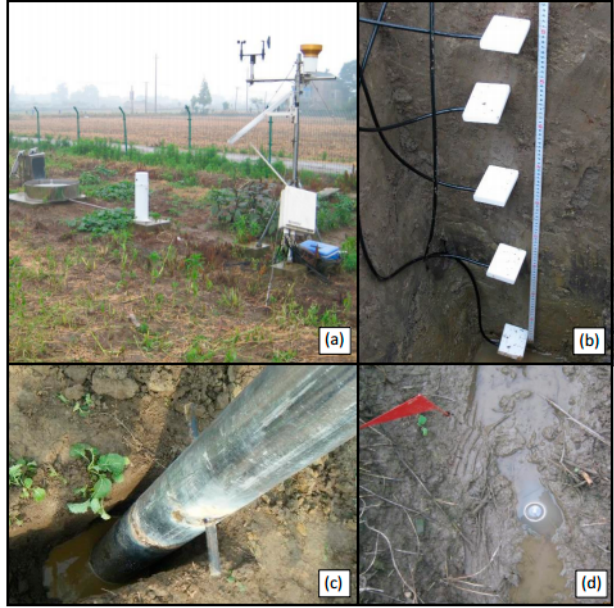
Figure 2. View of the some measuring instruments installed in the experimental field: ( a ) meteorological station; ( b ) soil water profile and sensors; ( c ) groundwater observation well; and ( d ) HOBO data